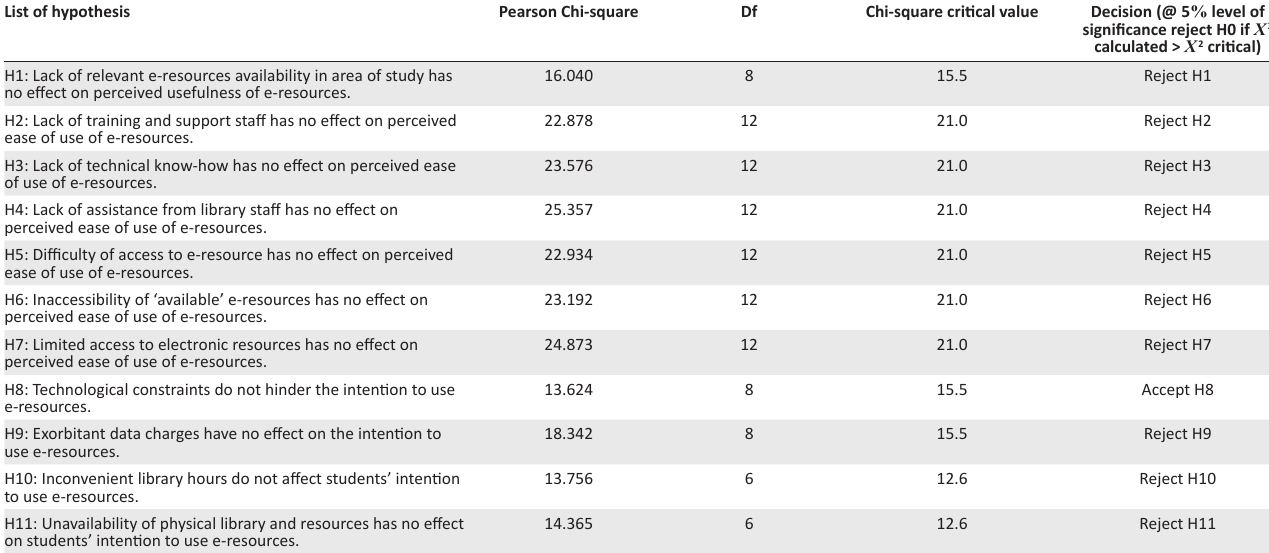
TABLE 1: Chi-squared analysis of hypothesis. List of hypothesis Pearson Chi-square